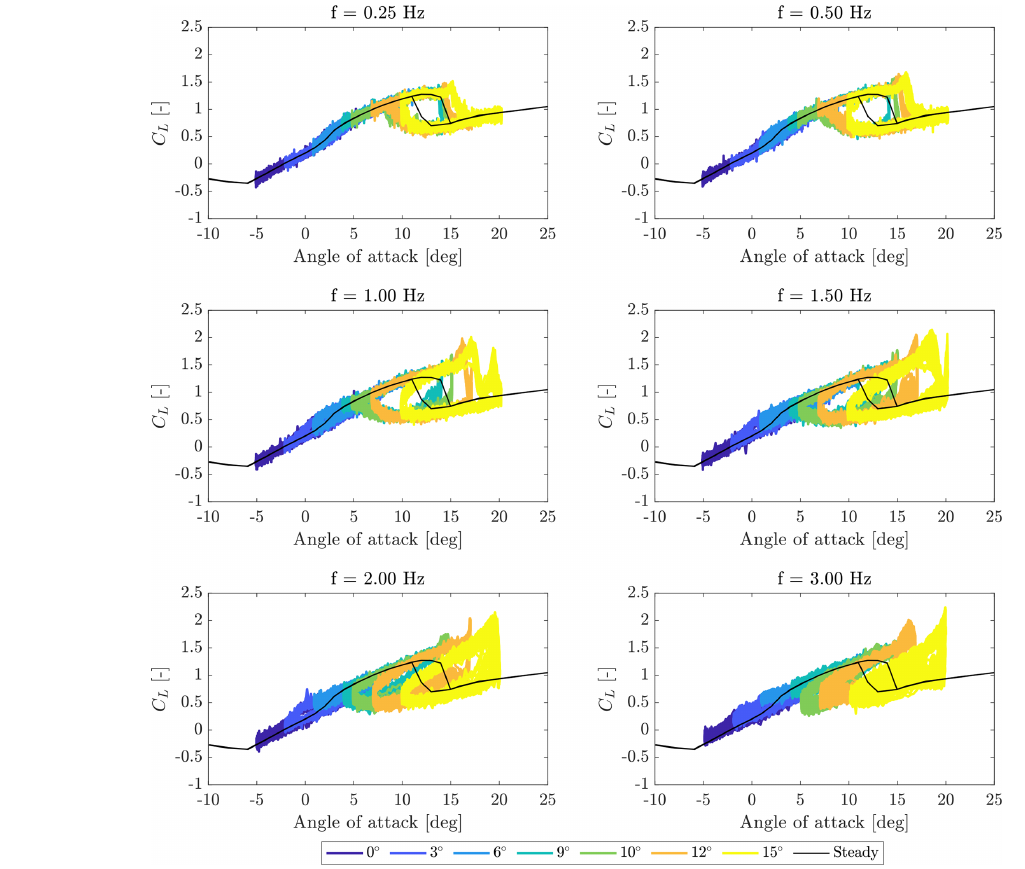
Figure 5. Unsteady lift coefficient ( C L ) for a sinusoidal angle of attack variation of 5 ◦ and different frequencies, with turbulent inflow and a chord Re of 50k. Colors denote the mean angle of attack, and the steady lift coefficient is reported in